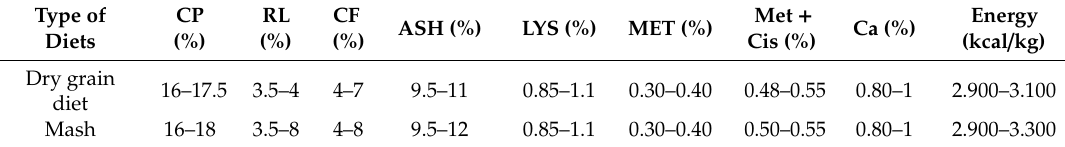
Table 2. Chemical composition of di ff erent types of diet as formulated and